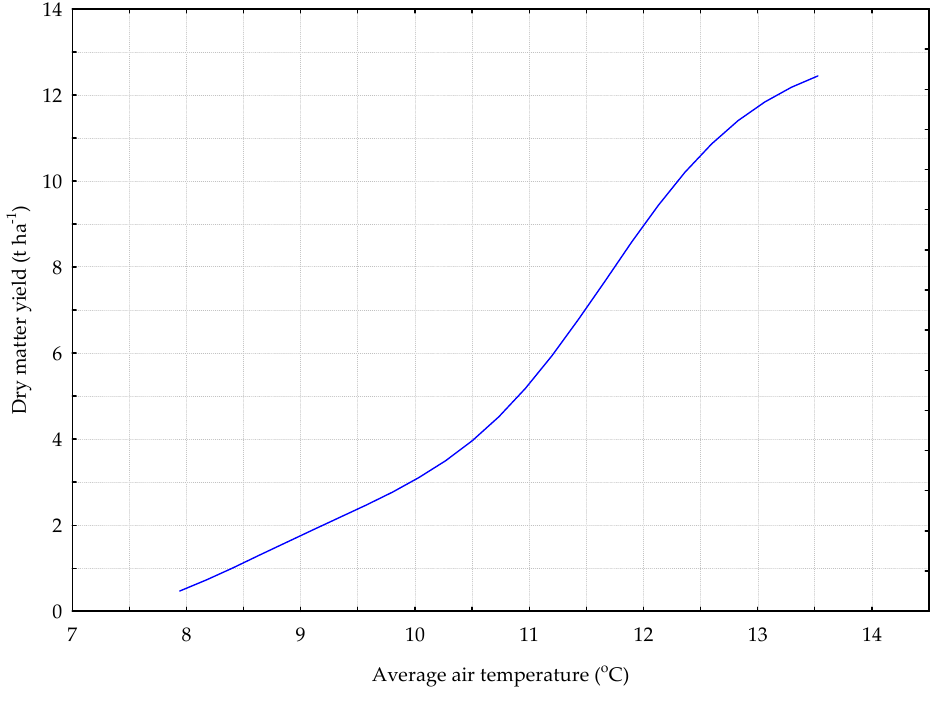
Figure 4. The Y_G model. The response chart for variables T_AV (rank 1) and Y_DM.